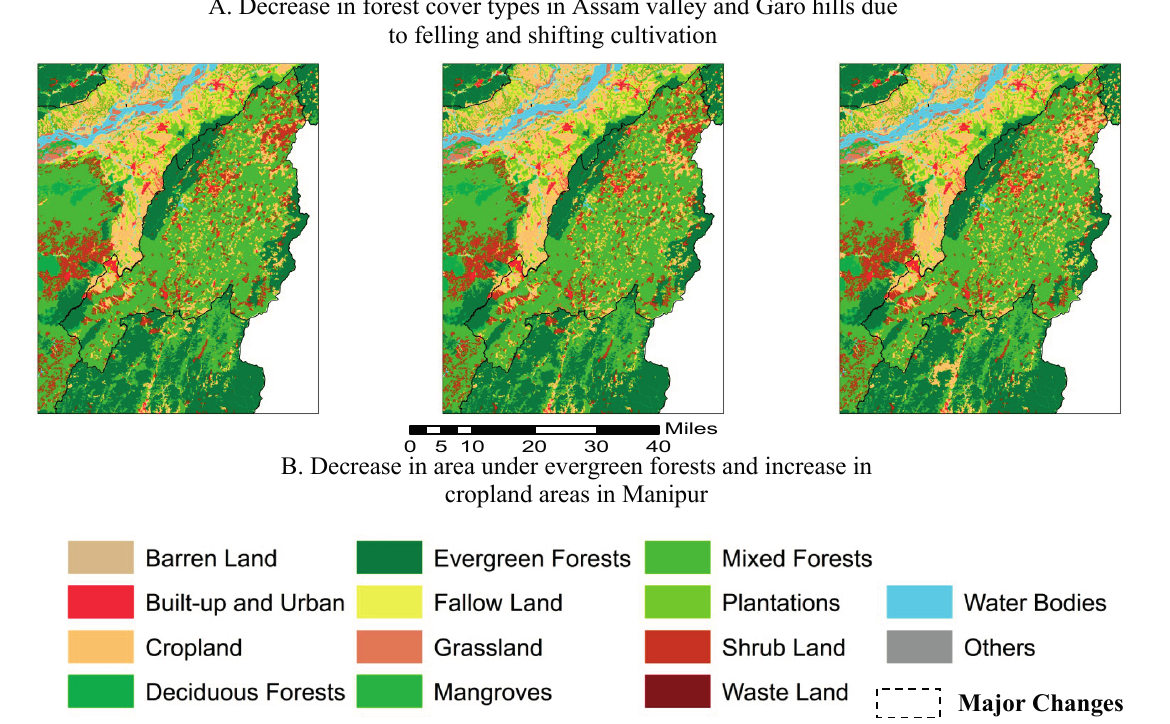
Figure 5. Landscape of North Eastern India presents dominance of forests and shifting cultivation. ( A ) Decrease in forest cover types in Assam valley and Garo hills due to felling and shifting cultivation and ( B ) Decrease in area under evergreen forests and increase in cropland areas in